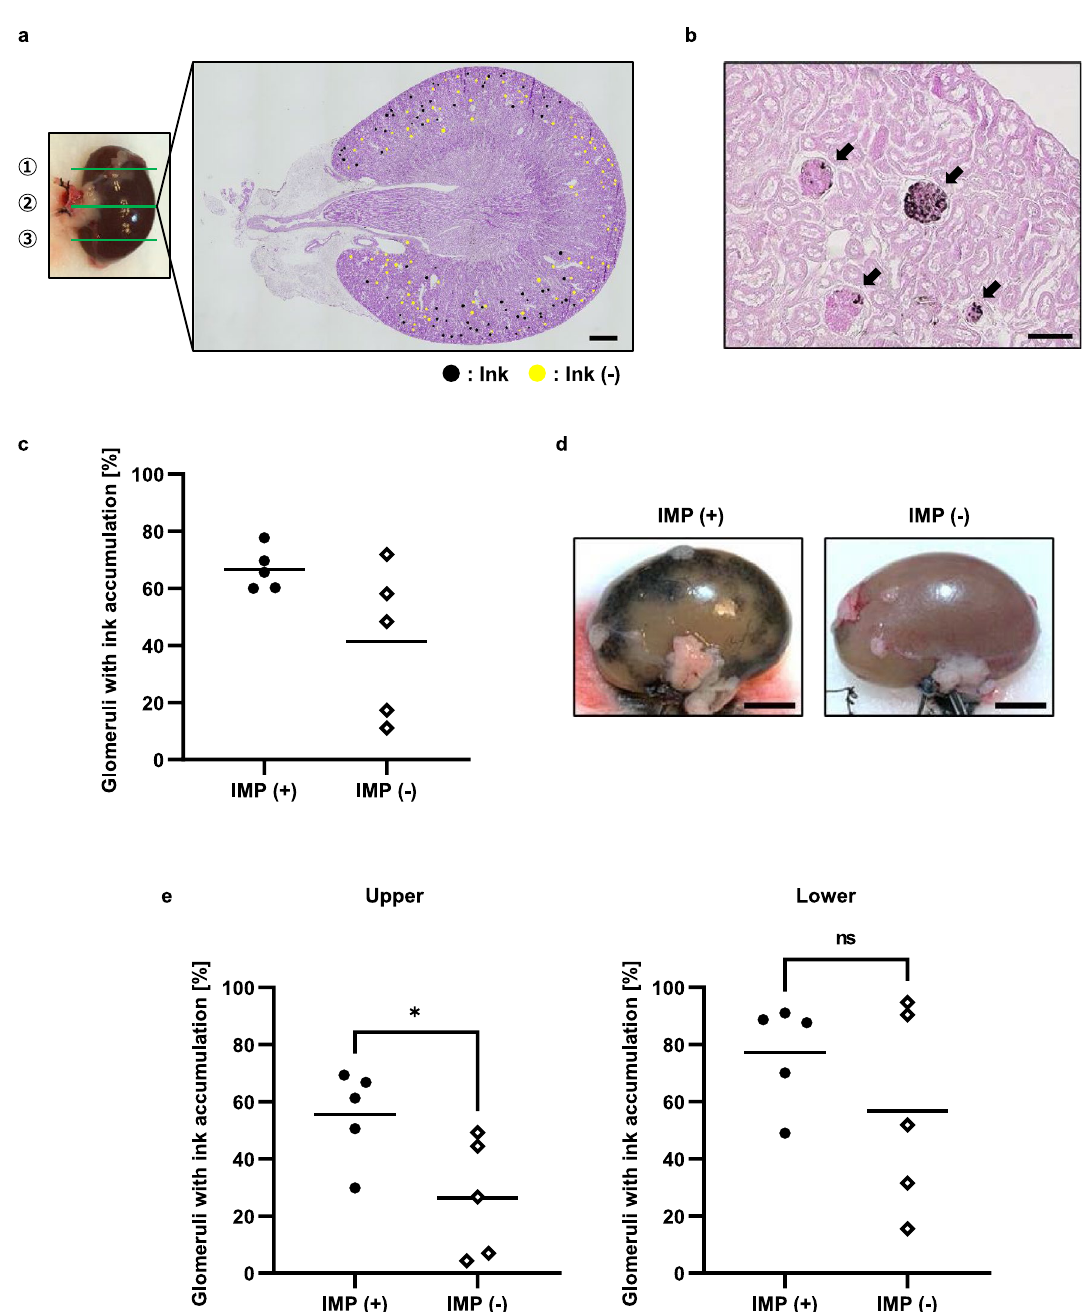
Figure 3. Short-term effect of intermittent pressurization on kidney perfusion. ( a ) Stained section for analysis of the intrarenal perfusion region. The green boxes indicate the three analyzed sites. Black dot: glomeruli with ink accumulation. Yellow dot: glomeruli without ink. Scale bars: 1 mm. ( b ) The stained image after ink perfusion. Black arrows: glomeruli with ink accumulation. Scale bars: 100 μm. ( c ) Point diagram comparing the percentage of accumulated glomerular counts after ink perfusion in the IMP (+) and IMP (−) groups. Fisher’s exact test. p < 0.05, n = 5. ( d ) The upper side of the kidney during ink perfusion in the IMP (+) and IMP (−) groups. Scale bars: 5 mm. ( e ) Comparing the percentage of glomeruli with ink accumulation on the upper side and lower side in the IMP (+) and IMP (−) groups. * p < 0.05, n = 5. ns not